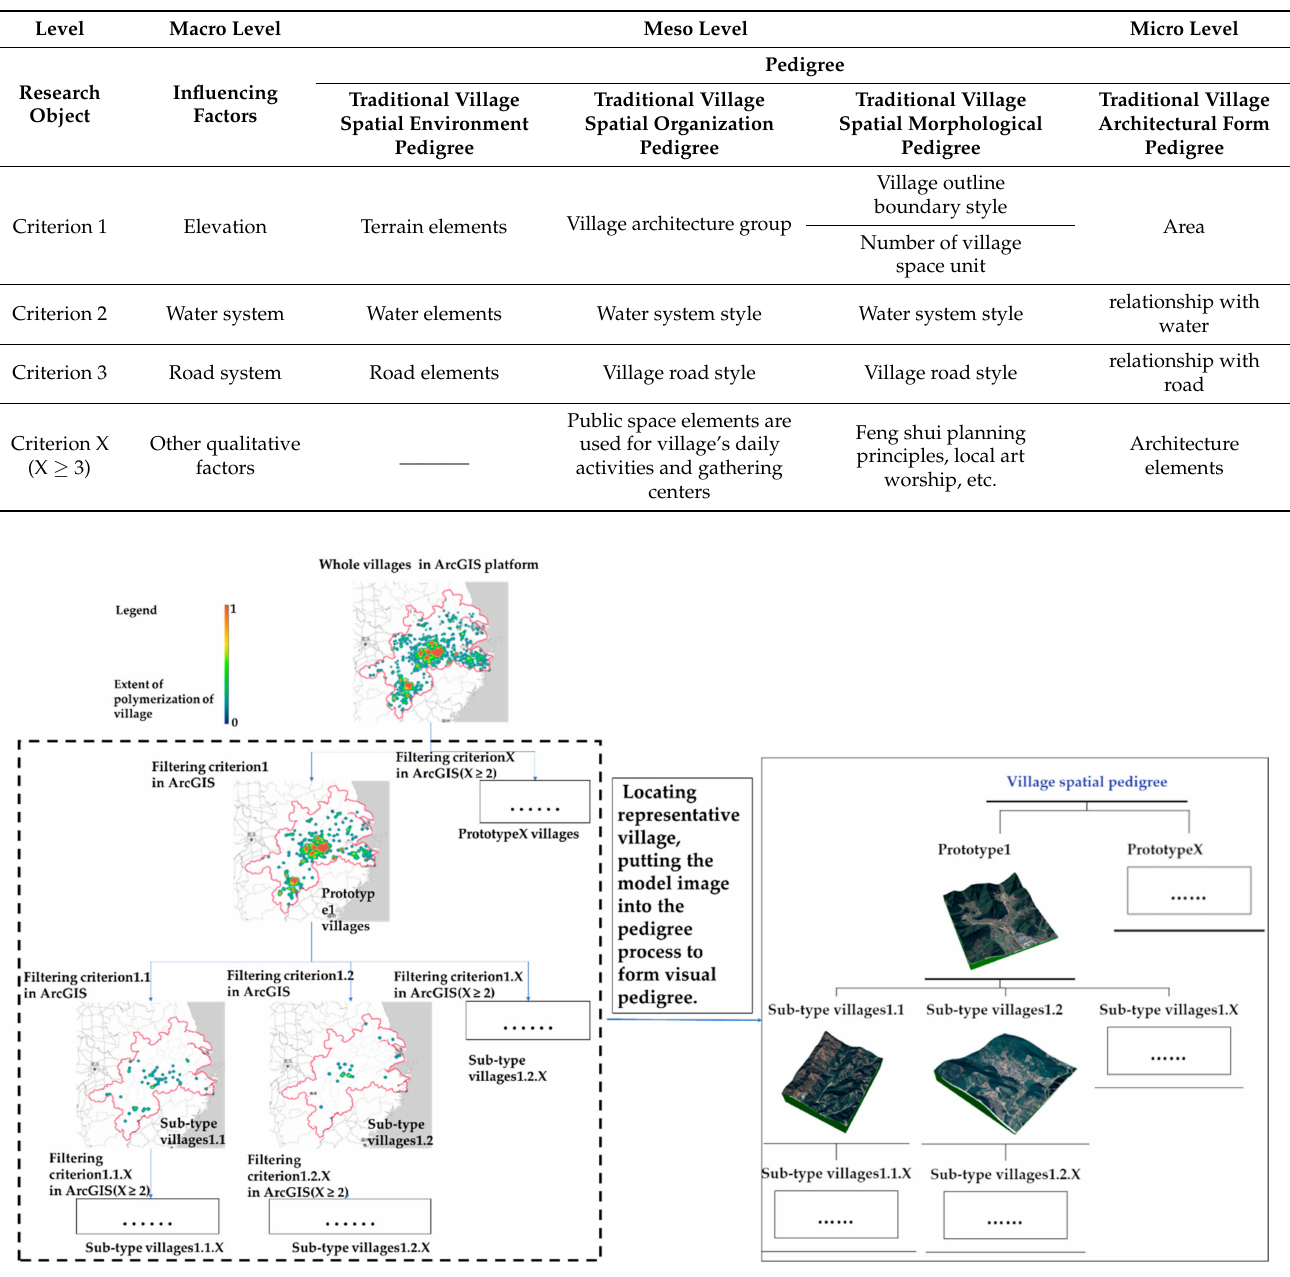
Table 5. The criteria for identifying the types of village spatial pedigree: edited by authors.